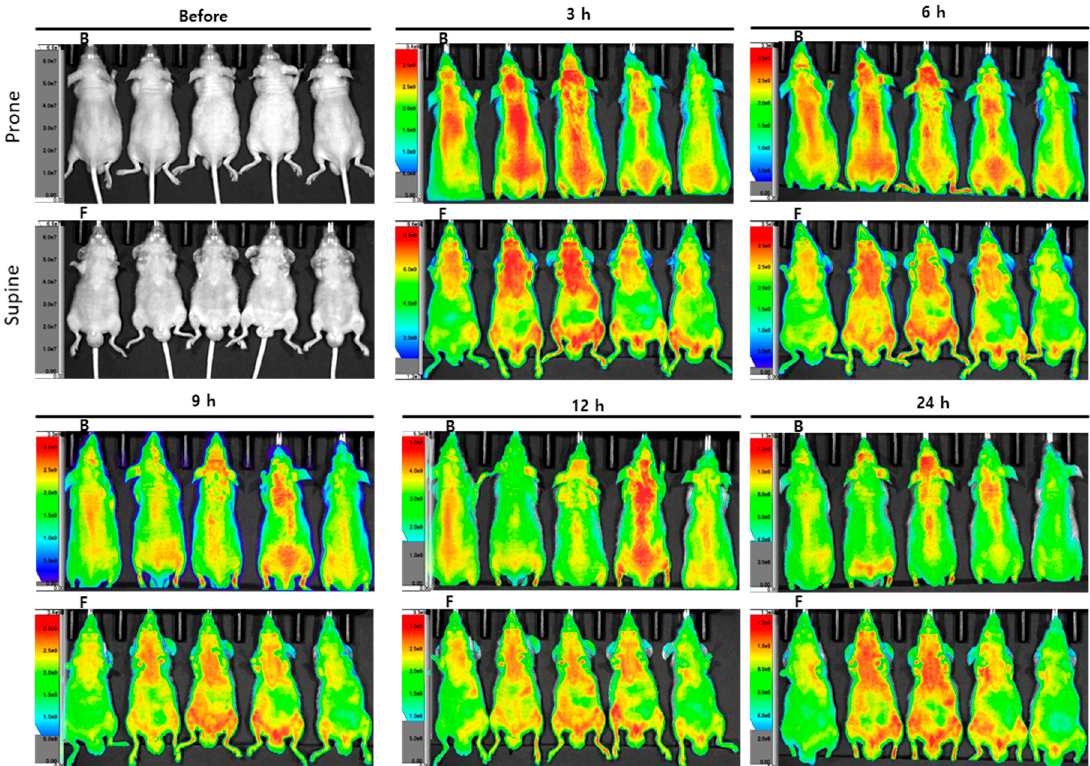
Figure 6. In vivo images of dehydrocostus lactone biodistribution. Image data of dehydrocostus lactone fluorescence at each time point after injection of Flamma® 675 thiol-conjugated dehydrocostus lactone. The fluorescence intensity was too strong in the skin area to distinguish the distribution in internal organs.